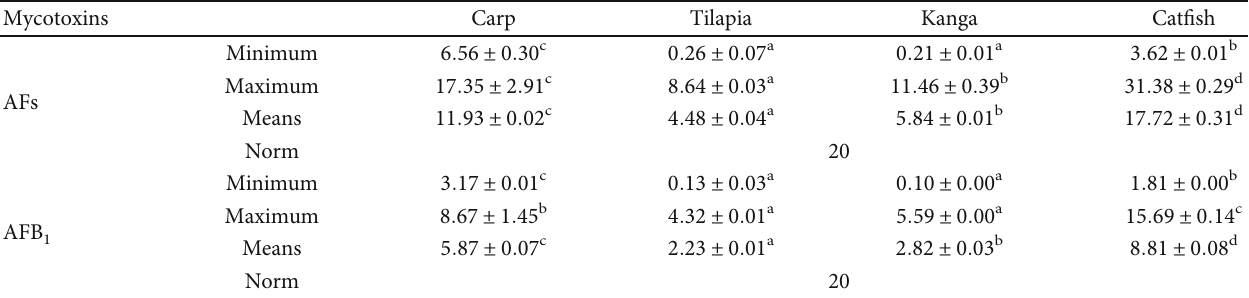
(AFB ) contents (ppb) of fi sh samples collected from the di ff erent farming ponds. 1 1